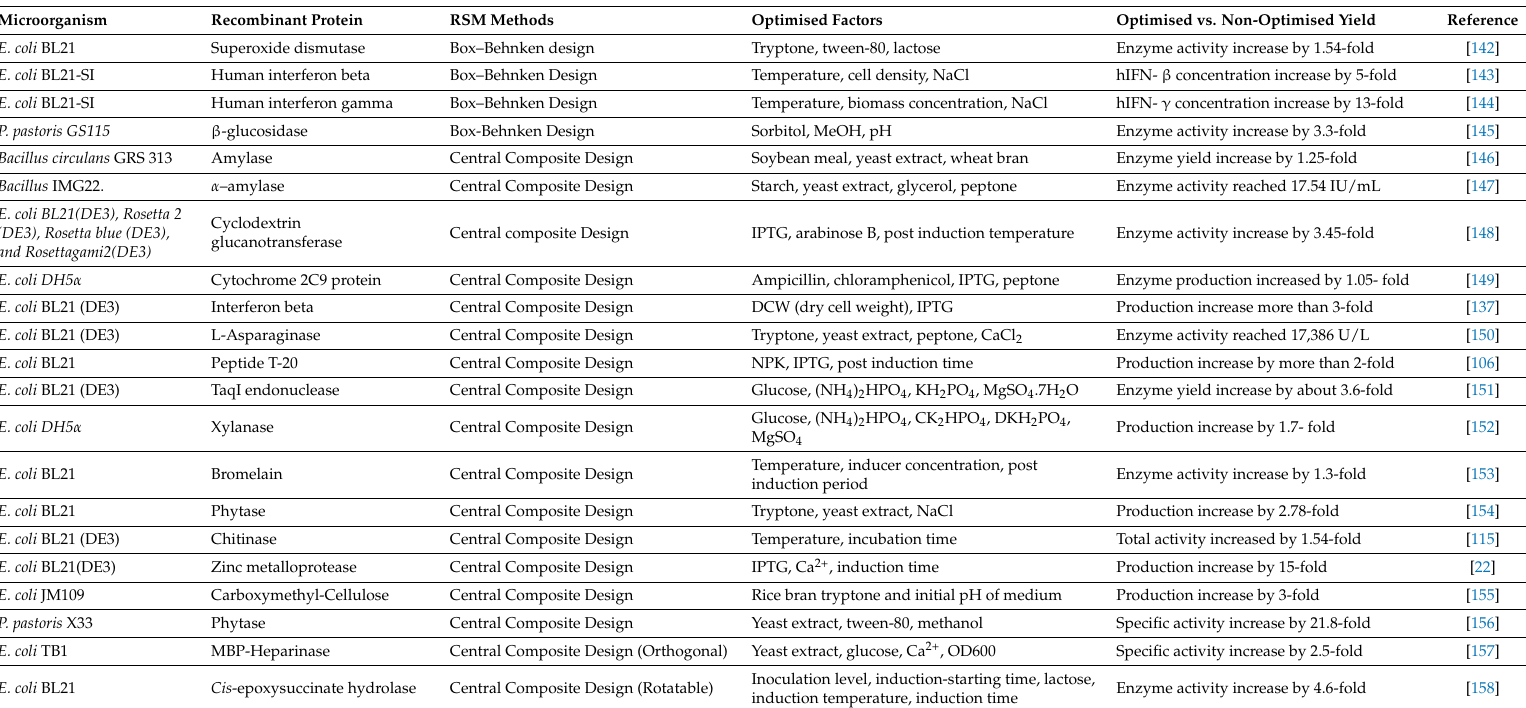
Table 7. RSM methods used to optimise the production of recombinant proteins along with their effect on yield and citing